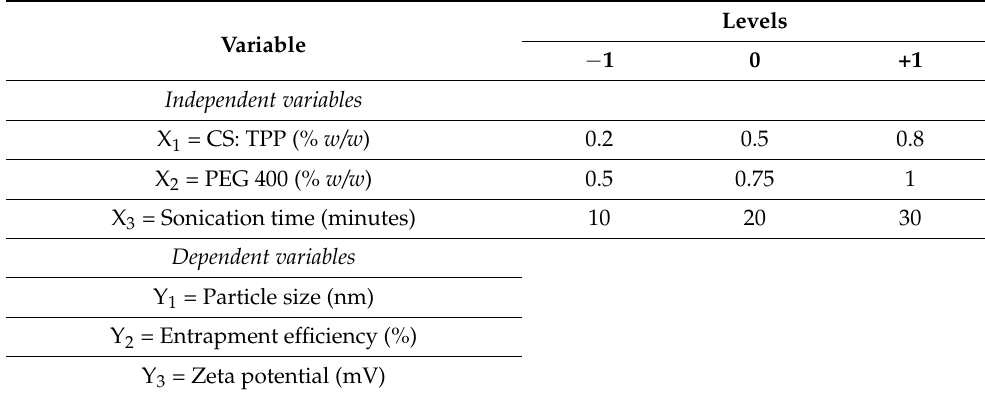
Table 1. Variables in BBD for formulation development of APG-loaded PEGylated-CNPs.